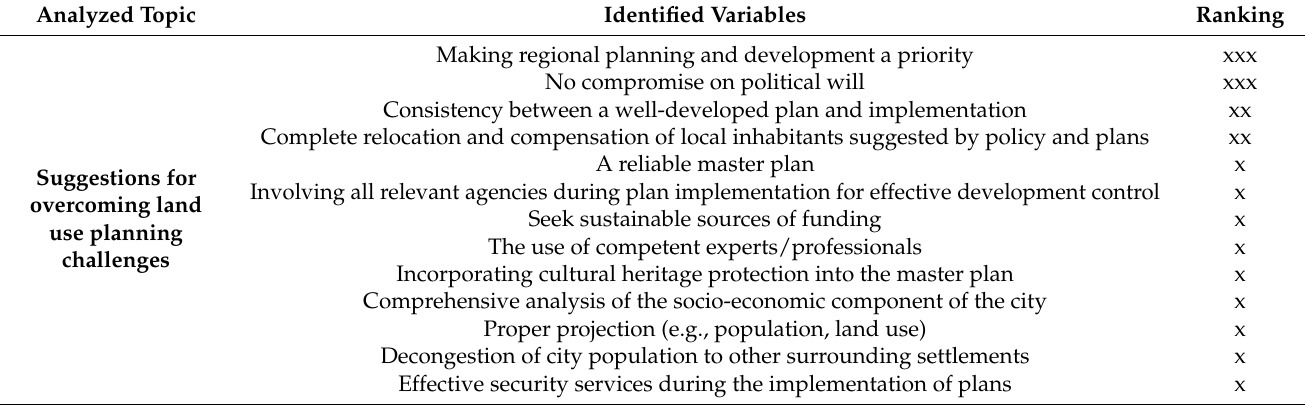
Table 9. Suggested solutions to land use planning